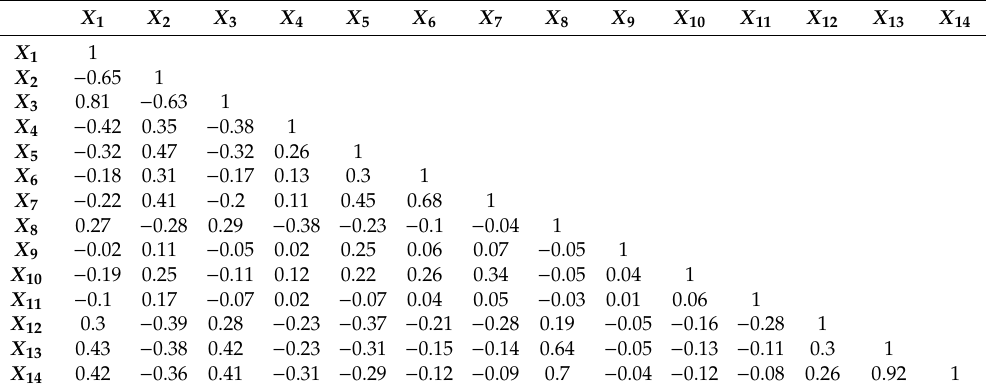
Table 3. Correlation matrix of the conditioning